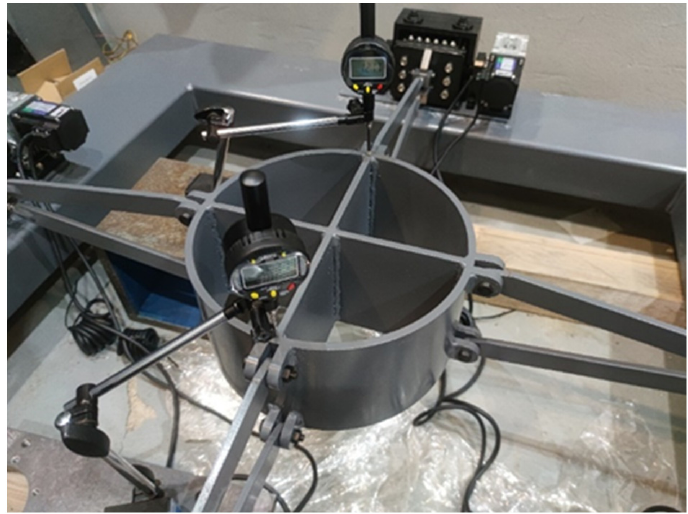
Figure 12. Deflection accuracy test with micrometers. Figure 13 shows the results of the measurements in the z-direction. The number of drive steps is the horizontal coordinate, and the displacement measurement after each movement step is according to the vertical coordinates. The actual position of each mea- surement is shown as a green dot and the theoretical position with a red dot. The red dot of the theoretical position is placed above the green dot of the measurement result. The greener dots in the graph give the absolute error between the actual measured and theoretical positions. If the theoretical position coincides with the actual measurement position, the red dot at that position covers the green dot and is shown as a red dot.